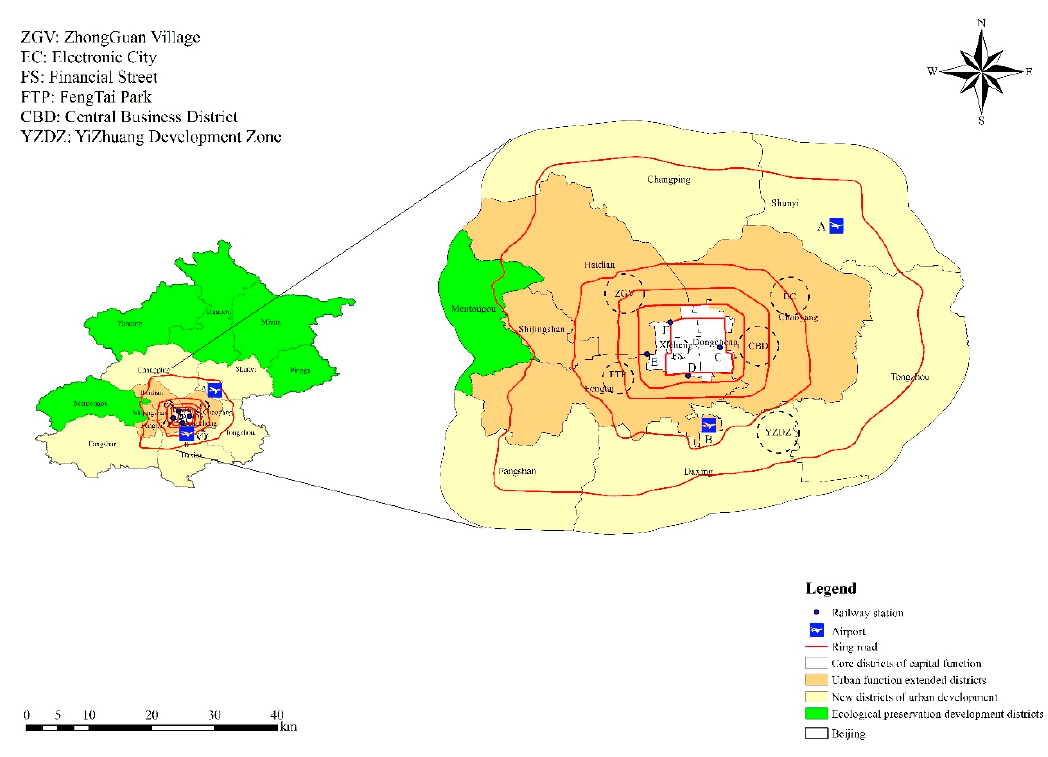
Figure 1. The Beijing study area.